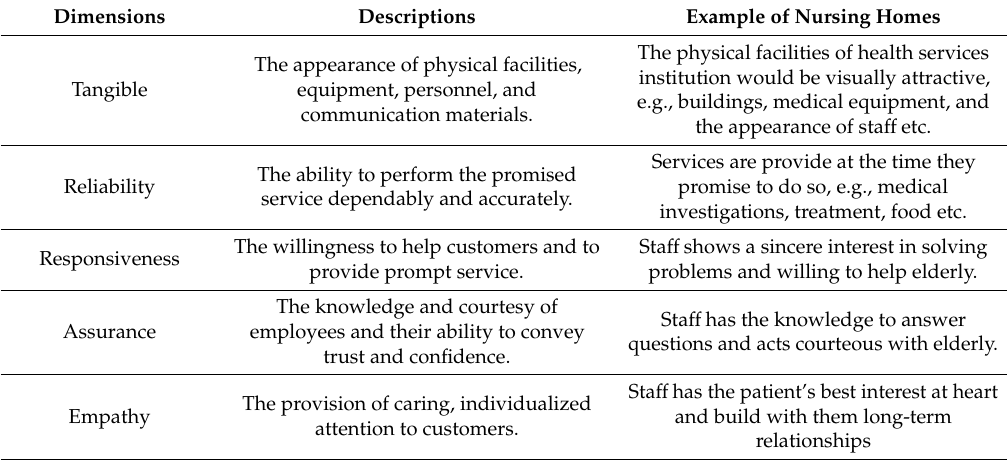
Table 1. Five SERVQUAL dimensions and descriptions applied in this